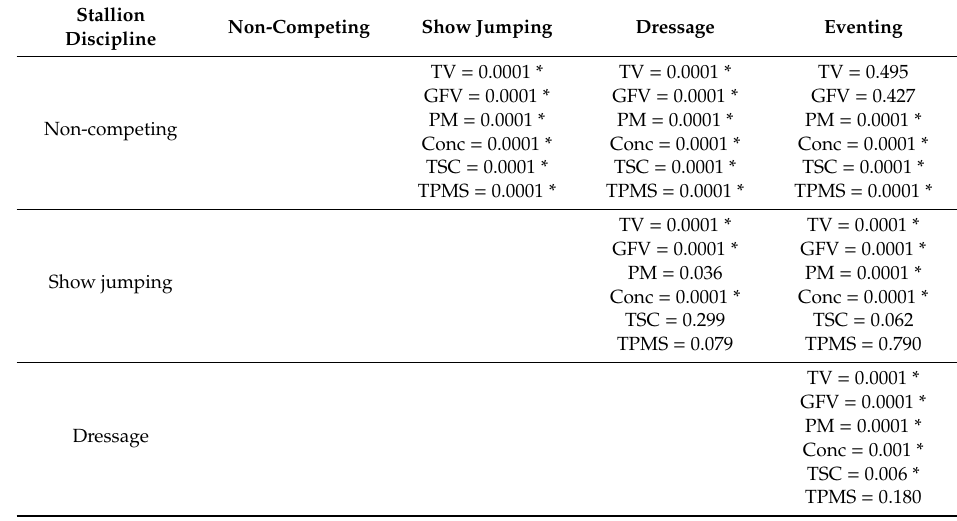
Table 4. Pairwise comparisons to identify where di ff erences in semen characteristics occur within stallion